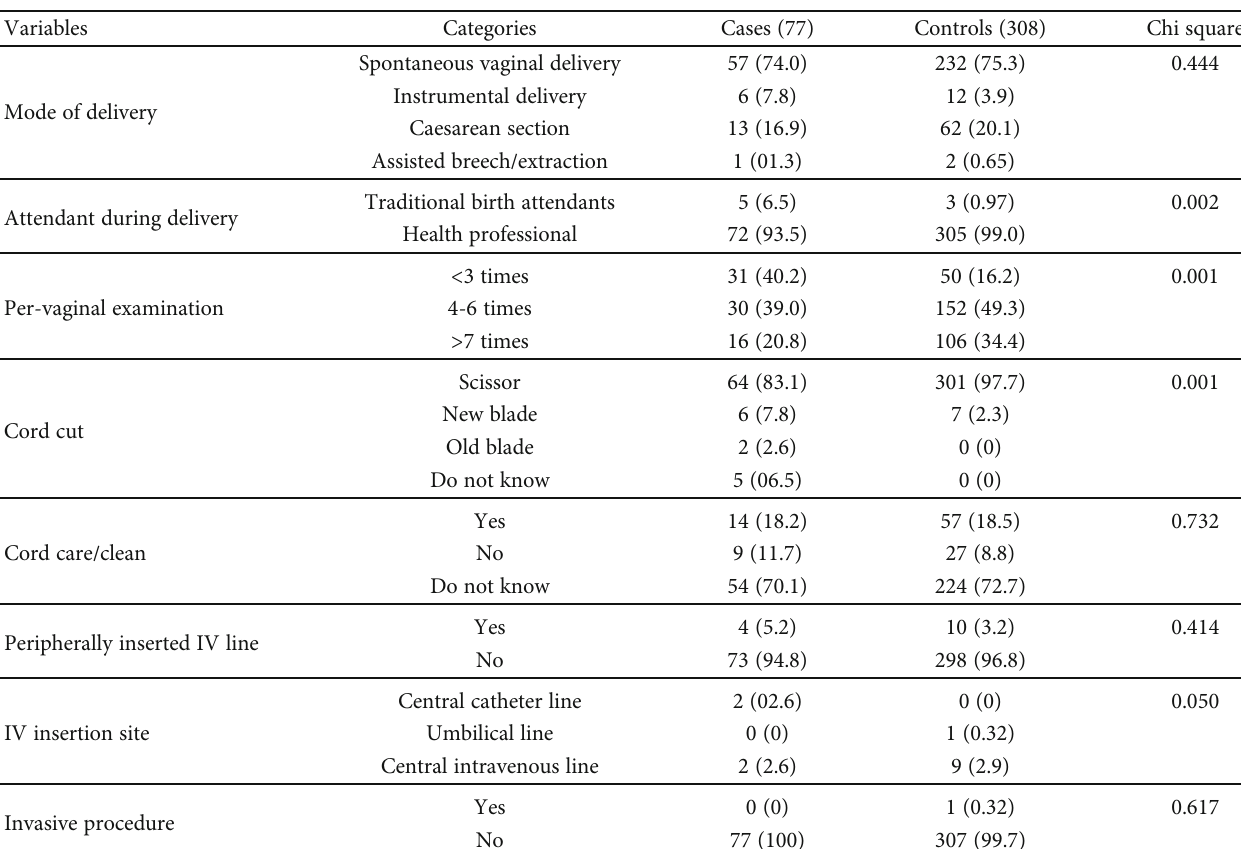
Table 5: Maternal and newborn clinical care-related factors of neonatal sepsis among neonates at SCGH and WSUTRH, Wolaita Sodo town,